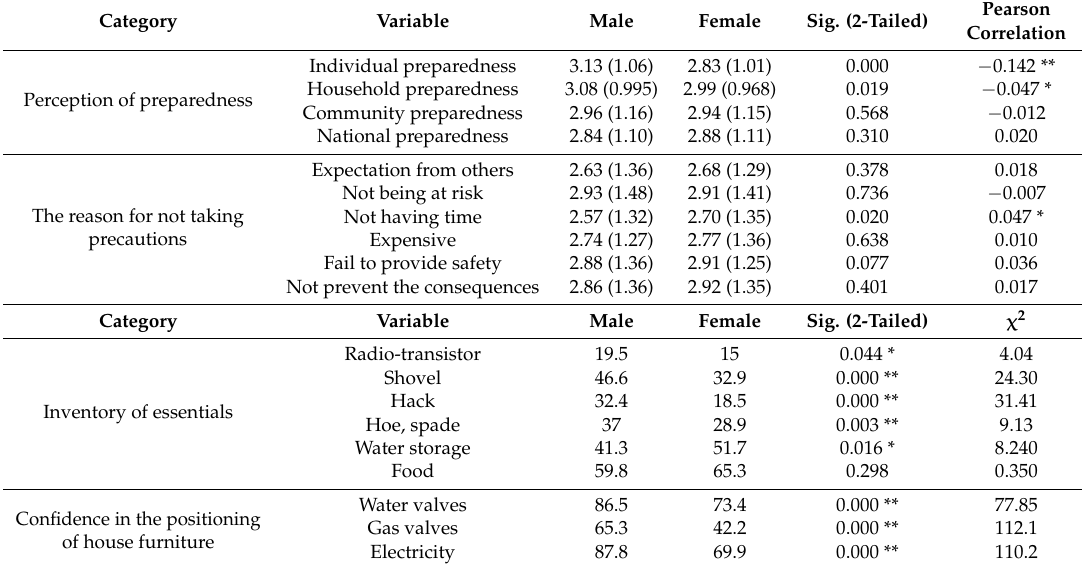
Table 7. Pearson correlation and Chi-square test results between flood preparedness and gender. Likert scales means are shown and standard deviations are presented in parenthesis for the first two set of variables.